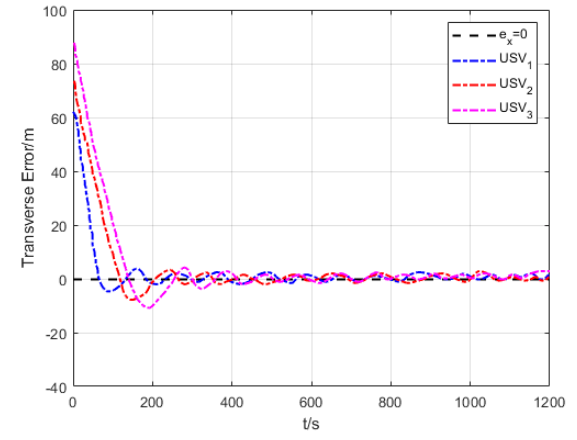
Figure 33. Variation of USV transverse